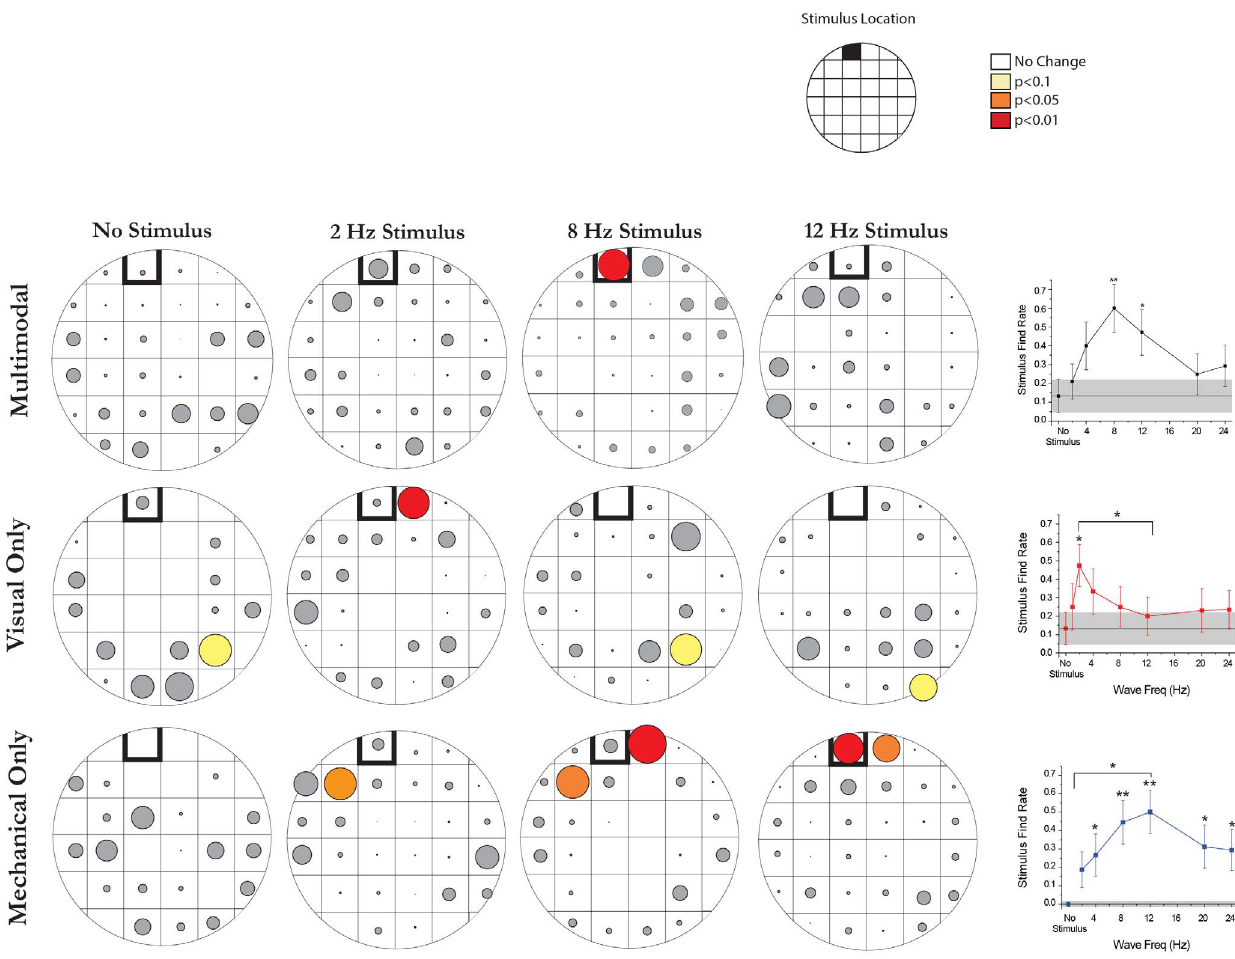
Figure 4. Scanning behavior becomes localized to a given stimulus. A grid of 32 squares was placed over the test arena. The amount of time a leech spent searching within each square of the grid was recorded. Because the first location of scanning behavior was influenced by the start location, we removed it from the calculation. The sum of time spent scanning by all leeches in each grid was calculated and then divided by the total time spent scanning for the group. This number resulted in the percent of scan time for a given region. Significant sectors are color coded: yellow for p , 0.1; orange for p , 0.05; red for p , 0.01. This process was repeated for each of the following conditions: multimodal stimuli; no stimulus (n=18), 2 Hz (n=13), 8 Hz (n=18), 12 Hz (n=11); visual stimuli; no stimulus (n=14), 2 Hz (n=17), 8 Hz (n=17), 12 Hz (n=10); mechanical stimuli; no stimulus (n=15), 2 Hz (n=15), 8 Hz (n=13), 12 Hz (n=16). Line graphs represent the percent of trials resulting in finding the stimulus under each of these conditions and are reproduced from Harley